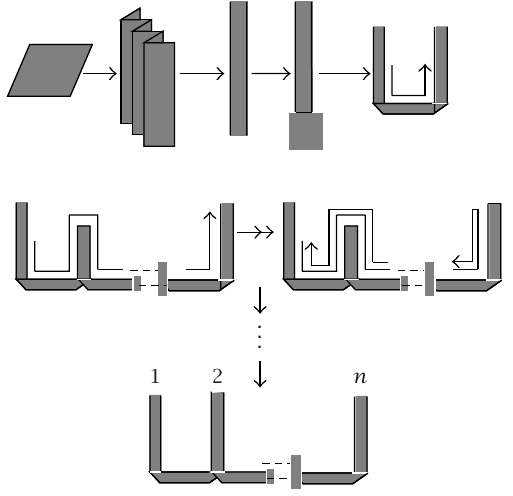
Figure 3.1. Planar folding with n ends.